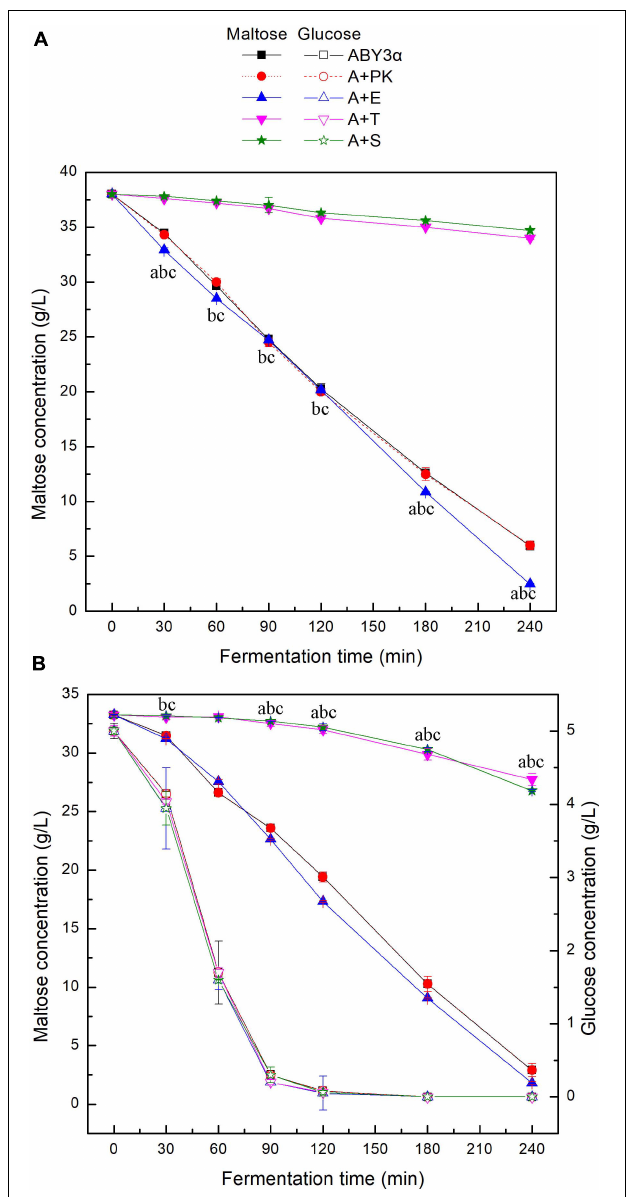
FIGURE 3 | Sugar consumption of the strains carrying genes overexpression in LSMLD media. 2 g fresh yeast was cultured in the (A) maltose and (B) maltose-glucose LSMLD media at 30 ◦ C and 1 mL cultures were sampled at a certain interval. ABY3 α , the parental strain; A+PK, the strain carrying the vector Yep-PK used as a blank control to demonstrate any possible effect of the empty vector; A+E, the transformant carrying ELM1 overexpression; A+T, the transformant carrying TOS3 overexpression; A+S, the transformant carrying SAK1 overexpression. Significant differences of the transformants